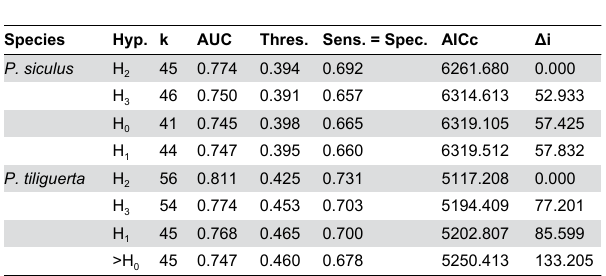
Table 1. Models performance and comparison.